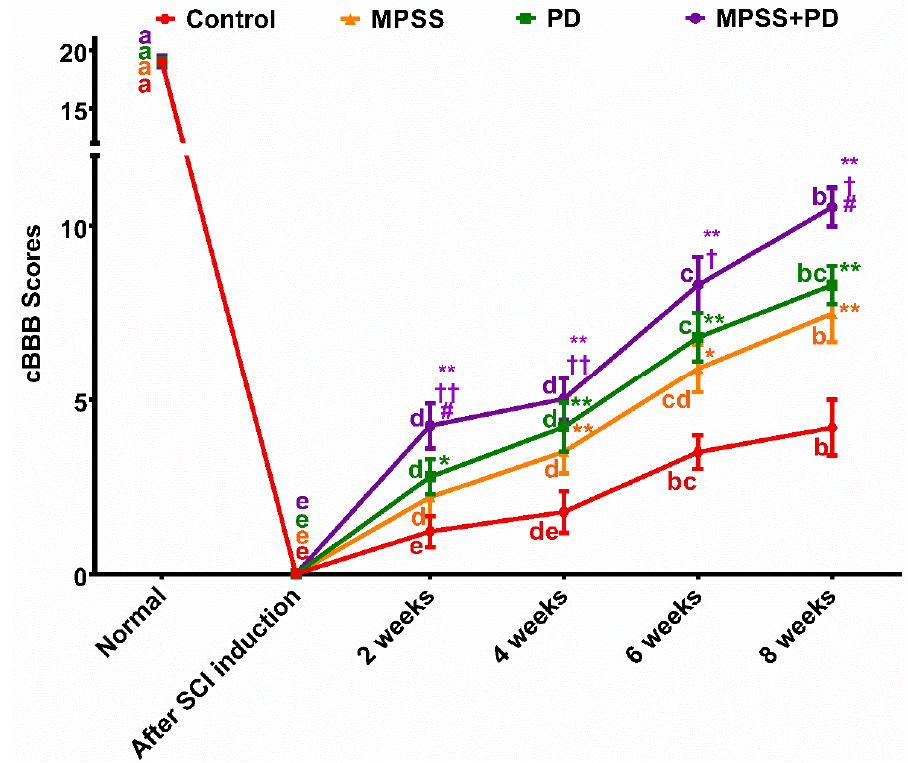
Figure 2. Locomotor scoring of SCI-induced dogs using the modified canine Basso–Beattie–Bresnahan locomotor rating scale (cBBB). Dogs were assessed before SCI induction, on the first day after induction, and subsequently weekly until the end of the study period. Data from different groups were compared to normal preoperative values (baseline). Data were represented as mean ± SD. At the same time point, * denotes significance compared with the control group at p <0.05, ** denotes significance compared with the control group at p <0.01, † denotes signi fi cance compared with the MPSS group at p <0.05, †† denotes signi fi cance compared with the MPSS group at p <0.01 and # denotes significance compared with the PD group at p < 0.05. Meanwhile, within the same group, different letters indicate significant differences p < 0.05.